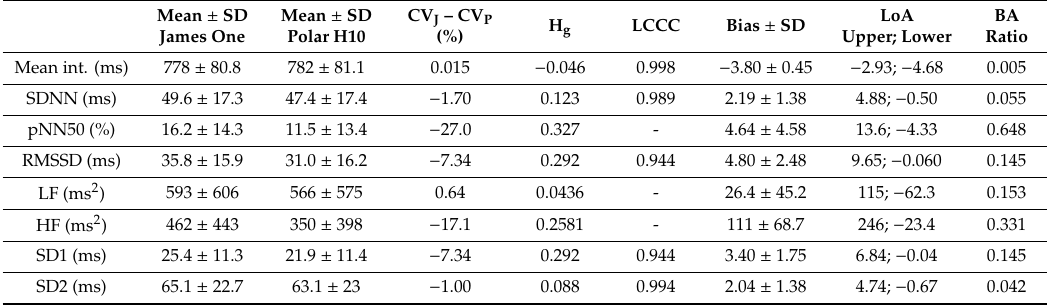
Table 3. Mean and the associated SD, differences between the CVs of the James One (CV J ) and the Polar H10 (CV P ), H g value, mean differences (bias) and the associated SD, for all the pairs of HRV metrics obtained at rest. Using Cohen’s guidelines, an H g value equal to 0.2 represents a small effect, 0.5 a medium effect, and 0.8 a large effect [38,39] . The agreement between the parameters is shown as LCCC. Values higher than 0.99 represent an almost perfect agreement, substantial and moderate agreement when lower than 0.99 and higher than 0.95, and a poor agreement if lower than 0.95 [41,42] . BA ratios lower than 0.1 represent a good agreement, higher than 0.1 and lower than 0.2 represent a moderate agreement, and higher than 0.2 a poor